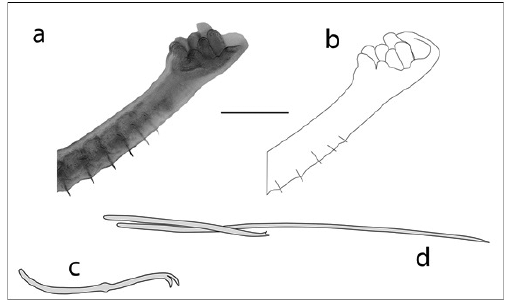
Figure 12. Dero ( Dero ) obtusa ; anterior end and typical chaetae: A photo of posterior end showing gill fossa (scale 250 µm) B outline drawing of A C drawing of typical dorsal chaetae bundle D drawing of typical ventral chaeta.